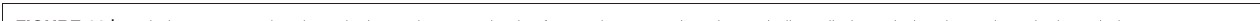
FIGURE 11 | prethalamus—crossing the reticular nucleus—and only afterwards access the telencephalic stalk through the alar peduncular hypothalamus—e.g., see Puelles and Rubenstein (2003, 2015); see also Figure 10 ; remarkably, Swanson (2012) still postulates implicitly in his rat flat map that thalamic fibers reach the telencephalon across a pial adhesion, and not through the prethalamus). (B) Is a modified reproduction of three drawings by Schwalbe (1880) illustrating how the lateral side of the embryonic thalamus progressively deforms into a caudally oriented direction as a consequence of internal thalamic growth and parallel massive growth of the telencephalon and its stalk by the passage of numerous thalamocortical and corticothalamic fibers. Actually, the deforming (and enlarging) striped rostral thalamic boundary is not with the telencephalon, as imagined by Schwalbe, but with the prethalamus (compare C ). Lack of understanding of this deformation stands at the basis of the erroneous idea of a metathalamus containing the medial and lateral geniculate bodies as derivatives of a neuroepithelial region immediately “posterior’ to the main thalamus, which would have to be pretectal (see real topologic position of these primordia in Figure 7B , and comments in the text). (C) These two schemata were modified from originals in the work of Hochstetter (1919), who aimed to visualize the same thalamic deformation highlighted before by Schwalbe (1880). Hochstetter accepted like his predecessor the simplistic idea that the thalamus can directly contact the striatum (false assumption giving rise to the widely believed lamina affixa theory shown schematically in A ). Modern prosomeric neuroembryology emphasizes the fact that the prethalamic part of the diencephalon is an intermediate neuromere rostral to the thalamus, which does not disappear (compare Figures 5 , 10 ), and therefore must become intercalated at the thalamo-telencephalic transition in the fashion depicted in my changes to these schemata. The prethalamus (green and red areas) becomes deformed (both stretched radially and flattened rostrocaudally) into a rather thin territory placed all along the supposed interface of the thalamus with the telencephalon. The flattened prethalamus is depicted as a thin green band representing its dorsal pial surface that remains visible in dorsal perspective, accompanied by the similarly stretched dorsalmost prethalamic area, the red-labeled prethalamic eminence, also in dorsal perspective (PThE). The latter shows in this view both its original pial and ventricular surfaces, evaginated in part through the interventricular foramen into the medial hemispheric wall (what protrudes at the lateral ventricle next to the terminal sulcus, without needing any questionable adhesion, is the eminential prethalamus, and not the thalamus proper). The neighboring telencephalic basal ganglia are reinterpreted as including the lateral and medial ganglionic eminences (LGE in violet, MGE in light blue), and the MGE is further marked as containing periventricularly the BST complex, which contains in this view only the supracapsular stria terminalis. Finally, a line of black dots indicates the non-fimbrial sequential insertions of the forebrain chorioidal tela (see fimbrial insertion—fi- in A ). The complementary chorioidal insertion begins at thalamic levels (in front of the epiphysis) with the taenia thalamica proper (tth; right side), which ends at the velum transversum fold, or thalamo-prethalamic border at the chorioidal roof (vel.transv.; represented by thick transverse black bar). We successively reach next the small pre-foraminal and foraminal parts of the taenia prethalamica (new term introduced here), which extend the chorioidal insertion into the interventricular foramen, now attaching at the eminential prethalamus. From there the dot line proceeds along a post-foraminal prethalamic taenial region (tpth; right side) that courses along the stretched red PThE up to its apparent “caudal” end (note this is no real rostrocaudal course, according to Schwalbe and Hochstetter, because it remains within the deformed prethalamus). This post-foraminal prethalamic taenia correlates in topography with the classic “thalamic” chorioidal sulcus (chs; A , right side; this was previously held to correspond to an apparent attachment at the border between the pars affixa and the pars libera of the fissural chorioidal tela—compare A -, but is reinterpreted here as being prethalamic and relating in depth to the prethalamic reticular nucleus—compare Figure 12 ; it is to be noted that, since chorioidal tissue is essentially roof plate, it is impossible that the thalamus has a second chorioidal roof plate apart of the one that covers the 3rd ventricle). Once the stretched PThE ends above the optic tract, next to the posterolateral pulvinar and the LG (right side), the continuation of the non-fimbrial insertion line of the chorioidal fissure apparently jumps here from the diencephalon (prethalamus) onto the telencephalon. It is only here where we can truly see a taenial attachment at the infracapsular BST (tail portion), or, finally, at the medial amygdala. Here it meets the amygdalar tip of the fimbrial taenia. This sphenoidal taenia decorates the sphenoidal horn of the lateral ventricle, participating with the fimbrial taenia in the final part of the chorioidal fissure. This attachment characteristically is no longer associated to the stretched eminential surface that covers the prethalamic reticular nucleus (compare Figure 12